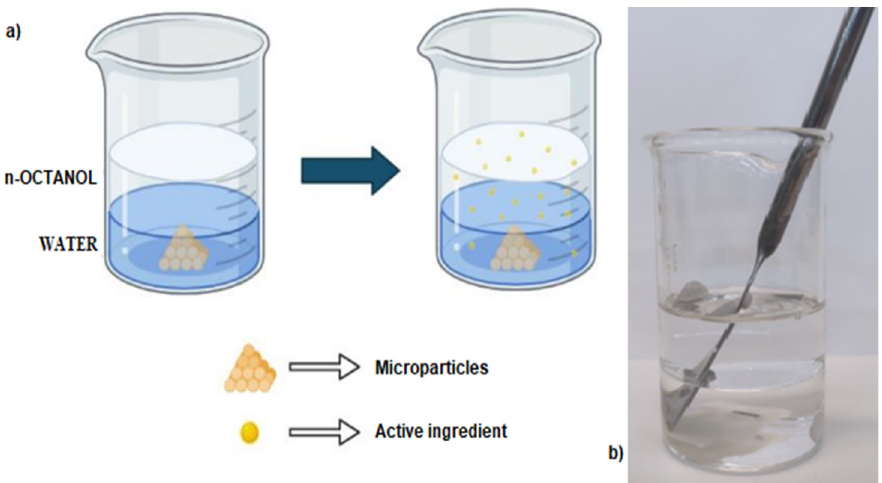
Figure 4. Scheme of the system used for the dissolution/distribution study of the microparticles (created with BioRender.com, accessed on 1 April 2022) ( a ) and photo of the model used experimentally ( b ).